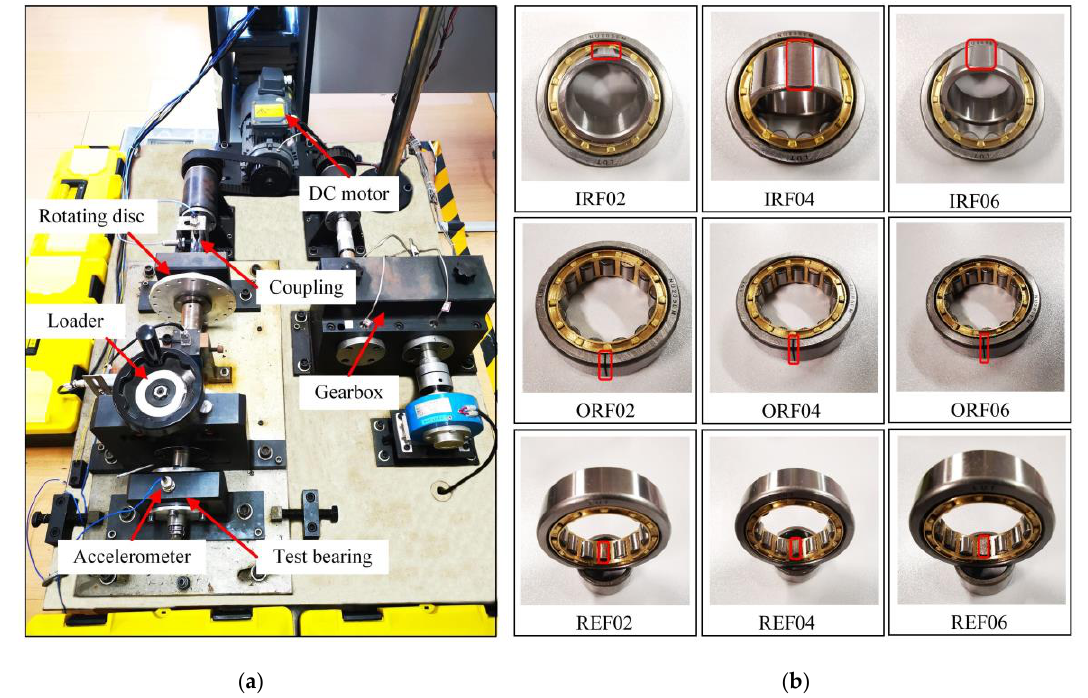
Figure 7. Rolling bearing fault diagnosis test bench and faulty parts: ( a ) test bench; ( b ) different types of faulty parts. Table 3. The information of bearing dimension.